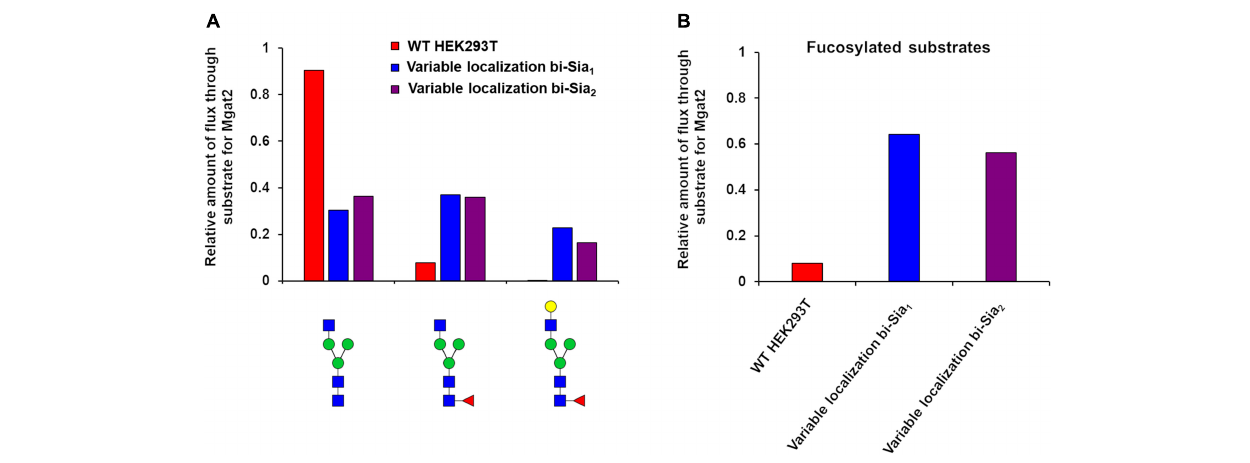
FIGURE 5 | Flux analysis of Mgat2 substrates in WT, bi-Sia 1 , and bi-Sia 2 simulations. (A) Proportion of biosynthetic flux carried by Mgat2 from its three dominant substrates in WT HEK293T cells (red) and the simulated profiles maximizing bi-Sia 1 (blue) and bi-Sia 2 (purple) fitted with variable enzyme localization. (B) The proportion of substrates for Mgat2 that are fucosylated for the simulations described in “ A .”